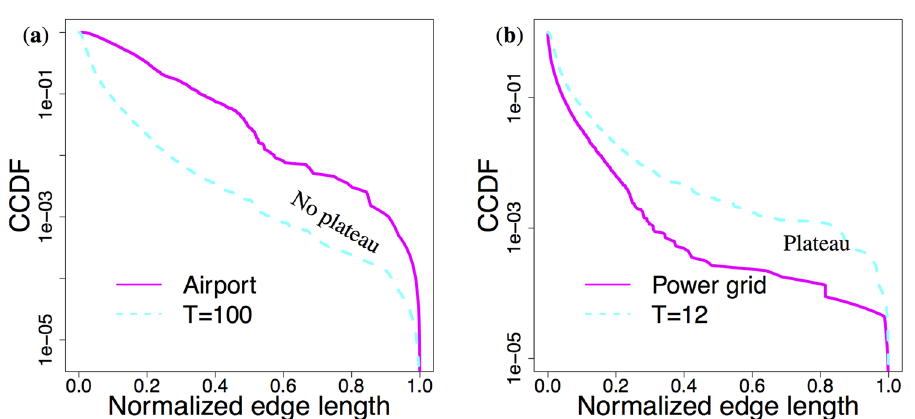
Figure 7. Edge length distribution in networks with different rich club organization. While panel (a) shows a continuously decreasing length distribution in case of rich-club networks, there is a clearly visible plateau before the cutoff of the CCDF function in networks having no rich-clubs (panel